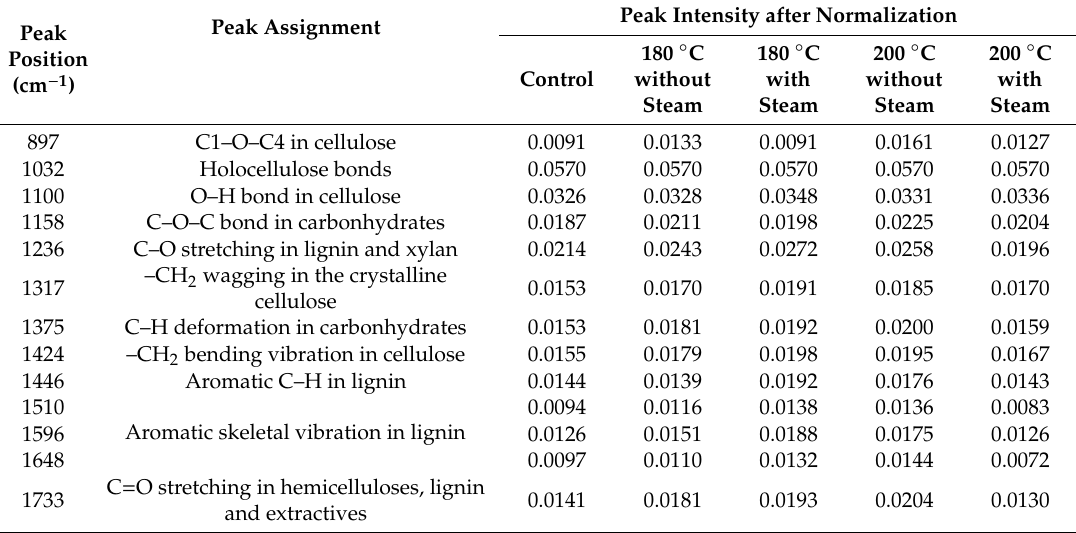
Table 2. Relative intensities of peaks after normalization.